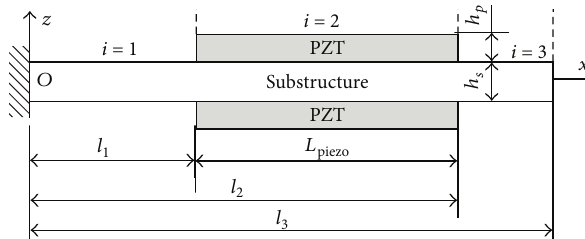
Figure 1: Bimorph piezoelectric laminated